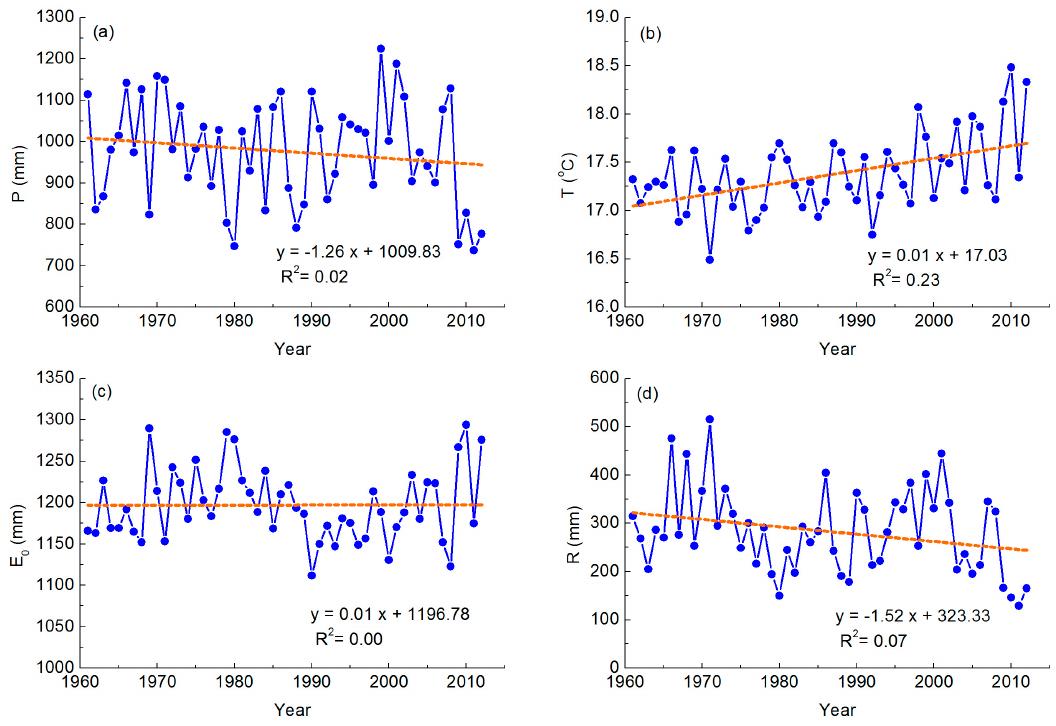
Figure 3. The variations of annual P ( a ); T ( b ); E 0 ( c ); and R ( d ) in the URRB during 1961–2012. Table 1. Mann–Kendall test for the annual P , T , E 0 and R in the upper catchment of the Red River Basin (URRB) during 1961–2012.